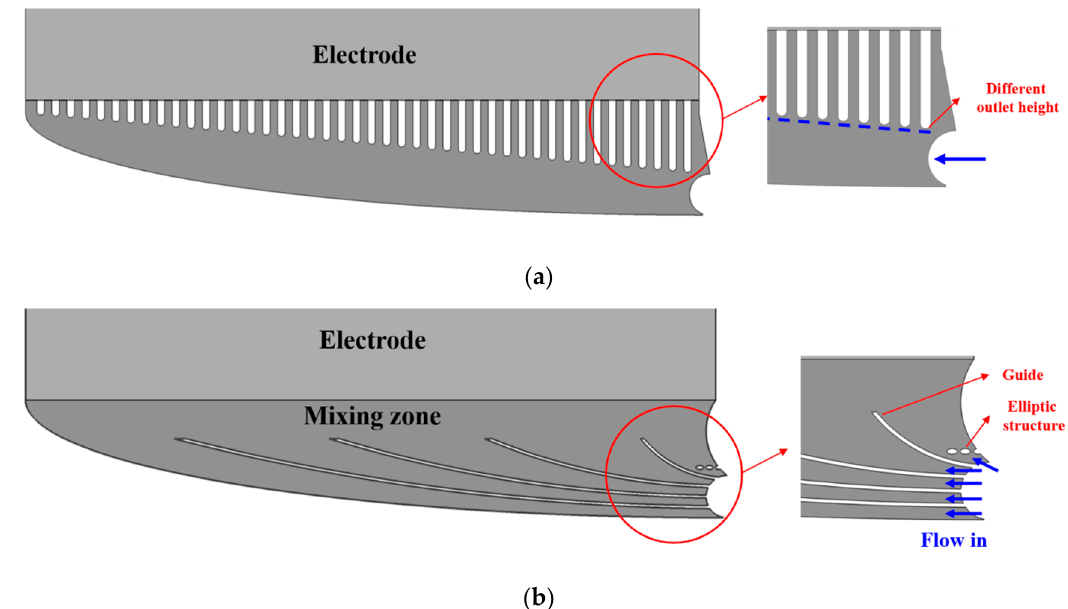
Figure 13. Two improved models of flow frame of vanadium redox flow battery. ( a ) CASE 1; ( b ) CASE 2.